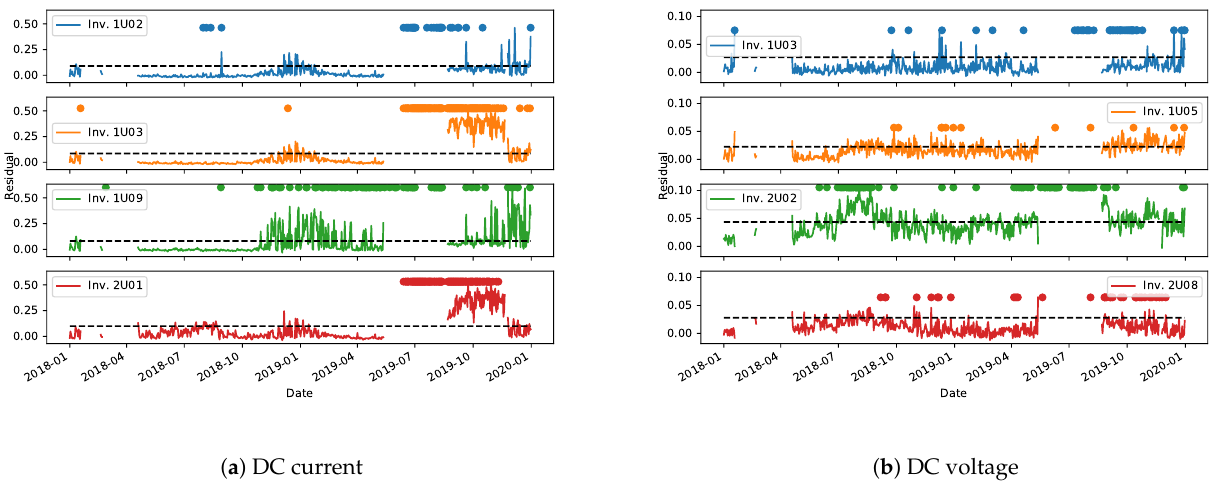
Figure 16. Control charts for anomaly detection on selected inverters from plant A. The dashed horizontal lines are the control chart limits, while the circles are the points in which the clustering algorithms detects an anomaly. Some time periods are not shown in the control chart due to missing data.